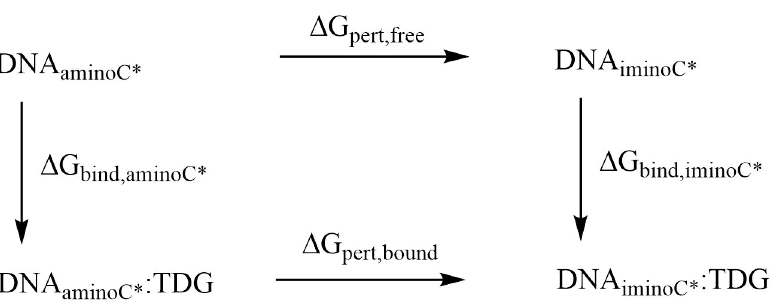
Figure 3. Thermodynamic cycle used for calculation of relative binding affinities.